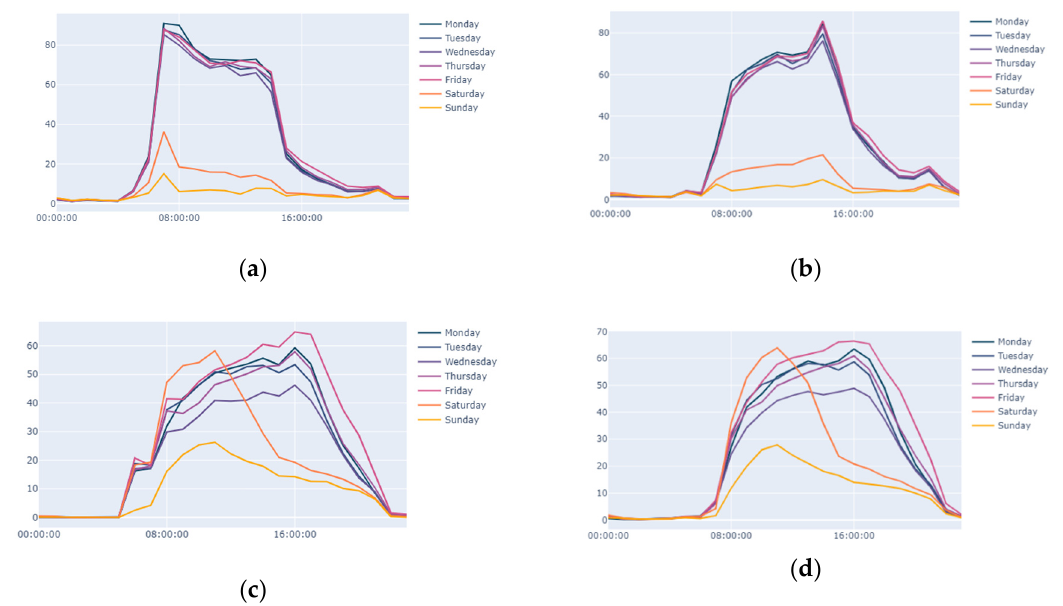
Figure A4. Average evolution of traffic in port gates, separated per direction. ( a ) Gate 10A—Entry; ( b ) Gate 10A—Exit. ( c ) Gate 16—Entry; ( b ) Gate 16—Exit.